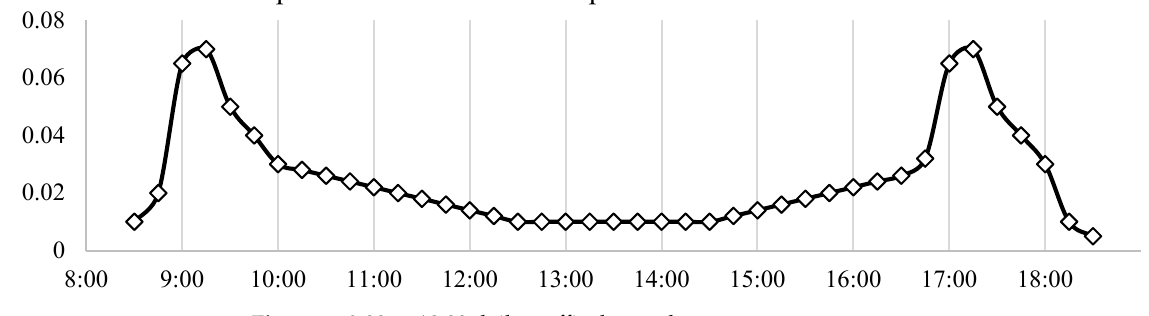
Figure 7. 9:00 to 18:00 daily traffic demand.